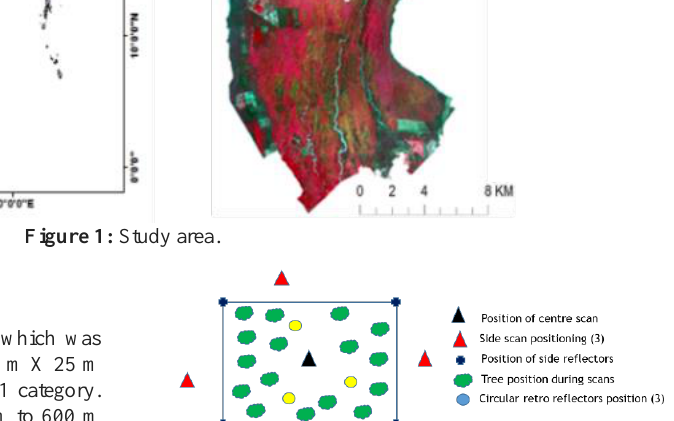
Figure 2: Schematic representation of scanning position in forest